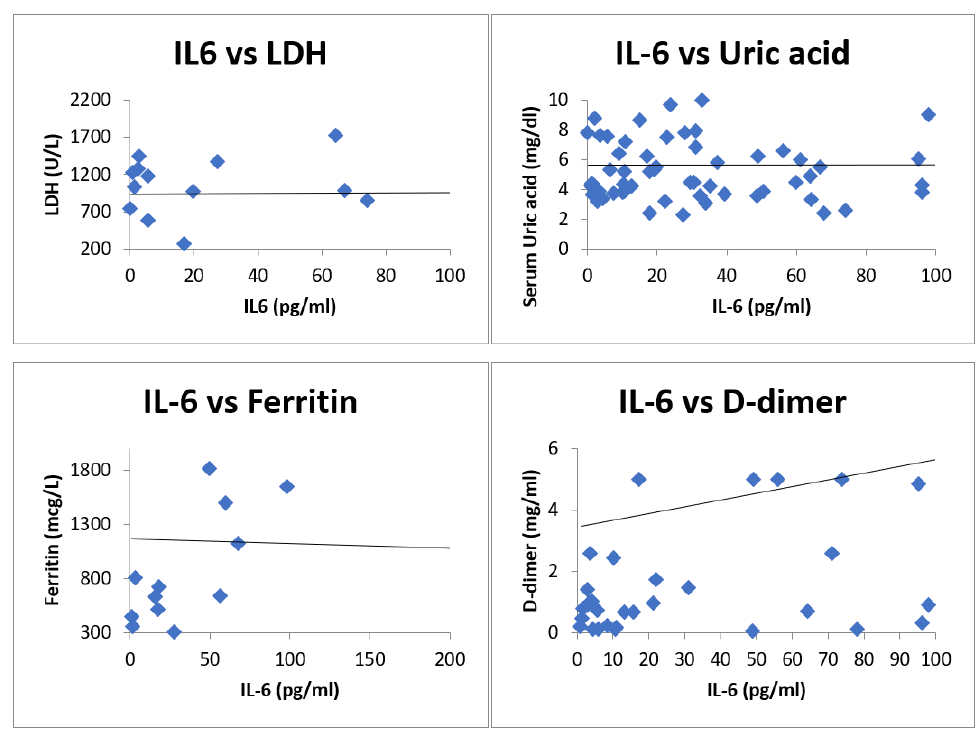
0.123( n = 77). Figure 2 shows the scatterplot of IL ‐ 6 with inflammatory markers.